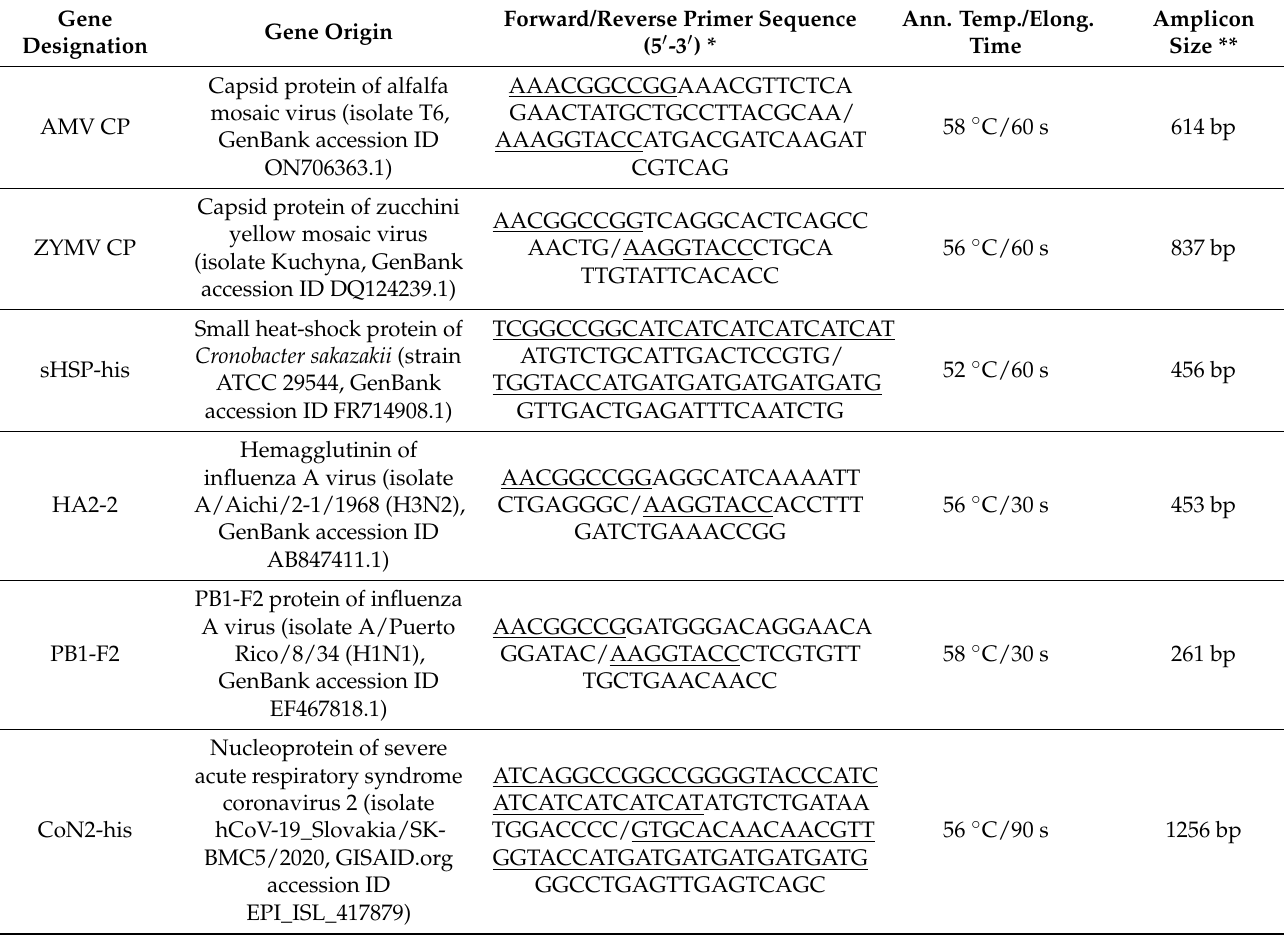
Table 1. Amplification details for target genes/gene